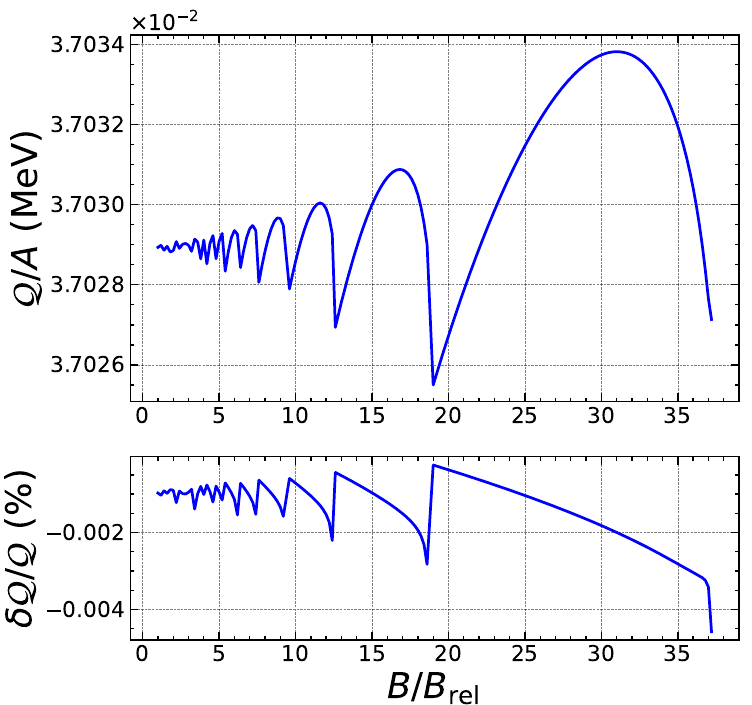
Figure 7. Top panel : Exact heat released per nucleon from electron captures by 56 Fe as a function of the magnetic field strength B (cid:63) = B / B rel up to the onset of the strongly quantizing regime. Bottom panel : Relative error (in %) of the approximate analytical